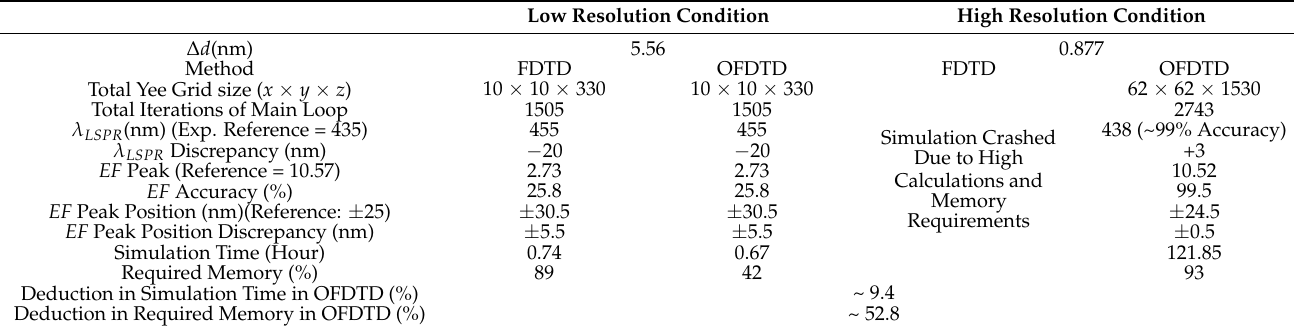
Table 3. Comparison of statistical results obtained by FDTD and OFDTD. Low Resolution